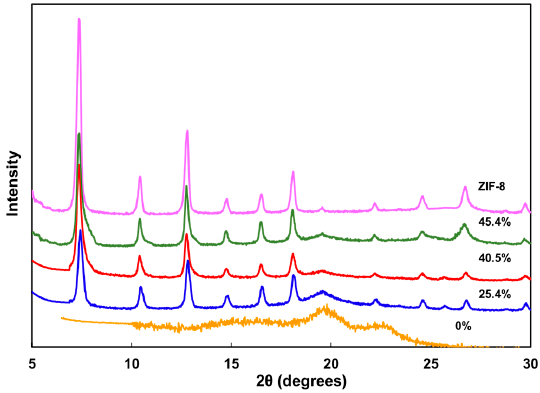
Figure 3. X-ray diffraction (XRD) patterns of PVA and PVA/ZIF-8 composites.